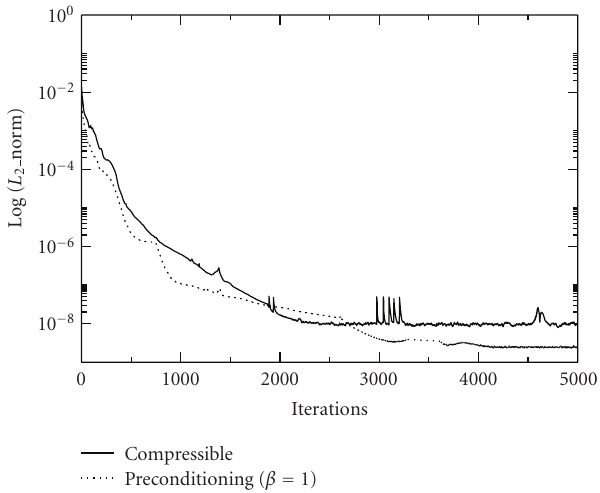
Figure 16: Convergence histories of a waisted body.